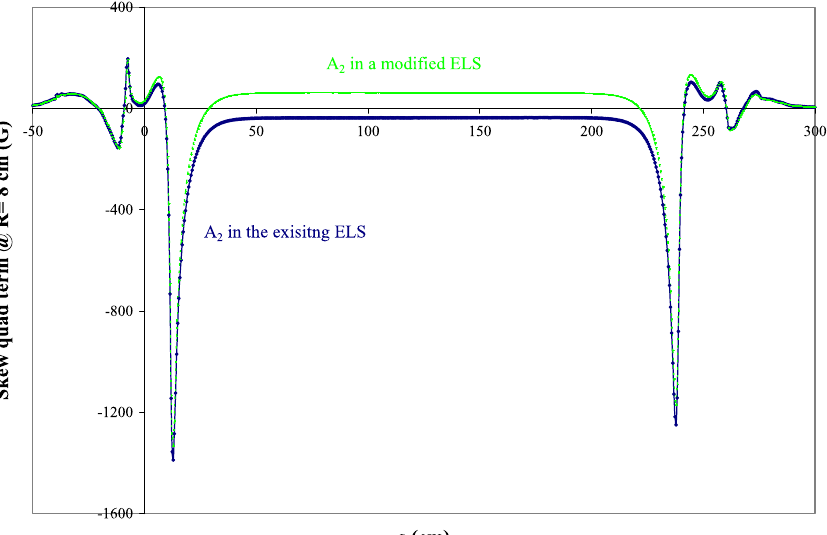
FIG. 18. (Color) Skew quad term of the field on a cylindrical surface surrounding a reference